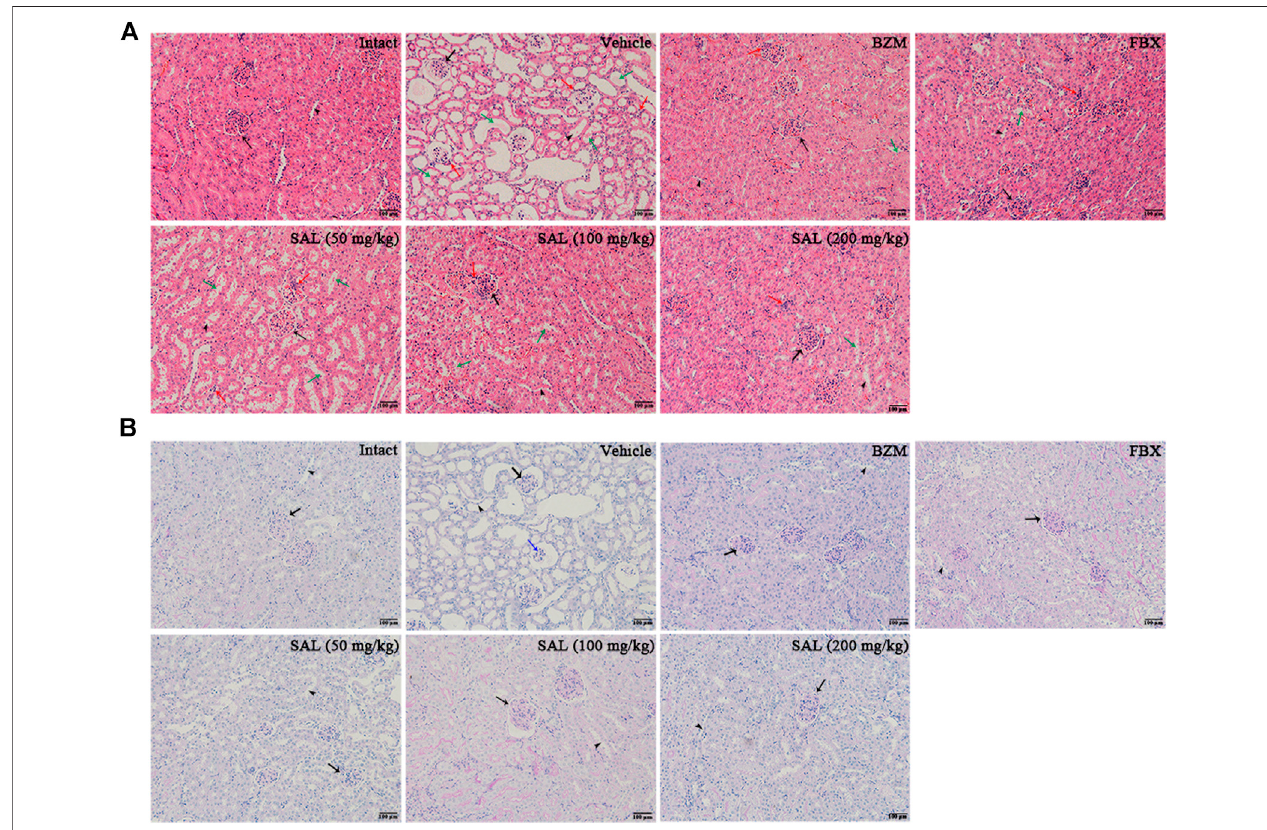
FIGURE2| EffectsofSALonrenalhistopathology. (A) HandE; (B) PAS.Magni fi cation: × 200.Scalebars:100 μ m.Blackarrows:glomerulus;sessilearrows:renal tubules; green arrows: epithelial cells exfoliation; red arrows: in fl ammatory in fi ltration; blue arrows: incrassated basement membrane.